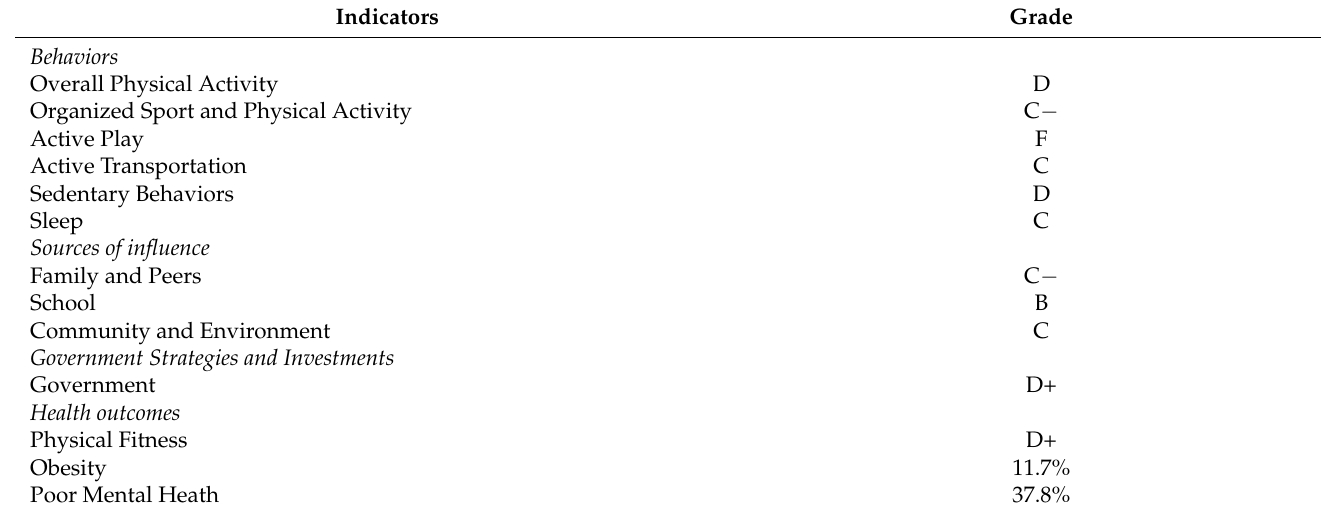
Table 3. Grades according to Physical Activity Indicator in the Report Card Brazil